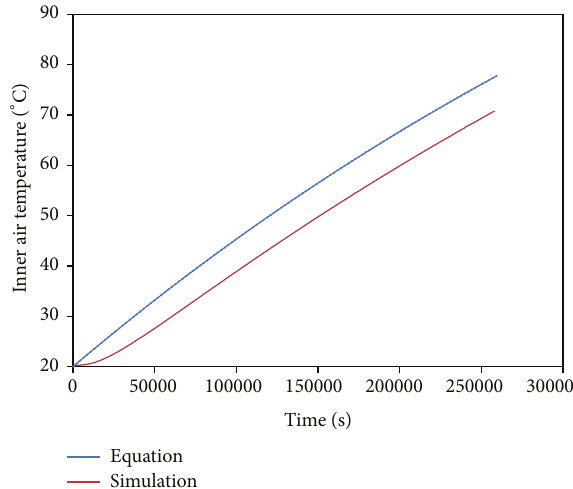
Figure 4: The result of simulation and temperature distribution at 𝑡 = 72 hours.